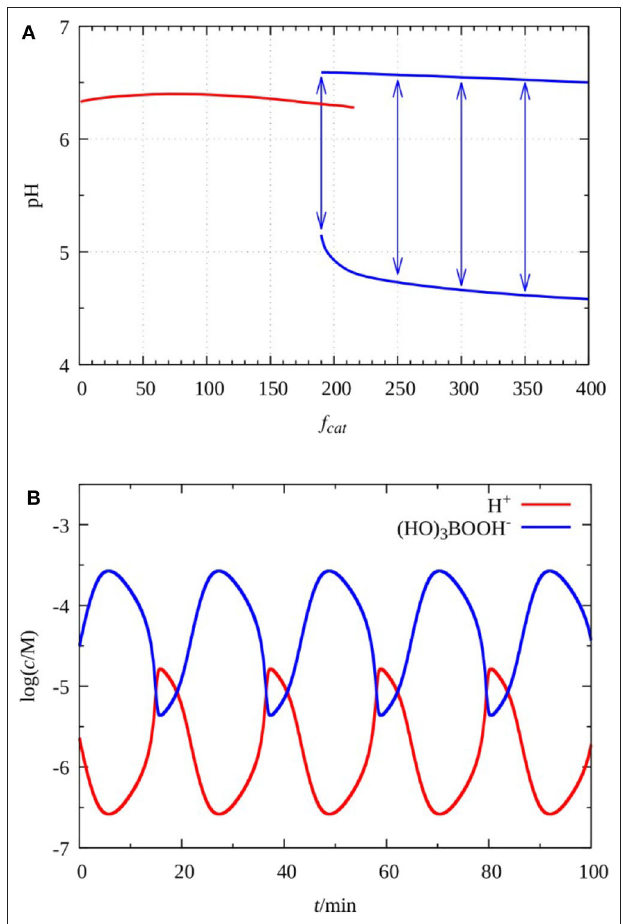
FIGURE 5 | Simulated bifurcations diagram as a function of parameter f cat . The arrows indicates the amplitude of oscillations (A) and oscillations in the concentration of H + and (HO) 3 B(OOH) − at f cat = 220 (B) . The parameters of the simulations k 0 = 0.002 s − 1 , [S 2 O 32 − ] 0 = 0.01M, [(HO) 3 B(OOH) − ] 0 = 0.062M, [Cu 2 + ] T = 1.5 × 10 − 5 M, [H + ] 0 = 0.066M.